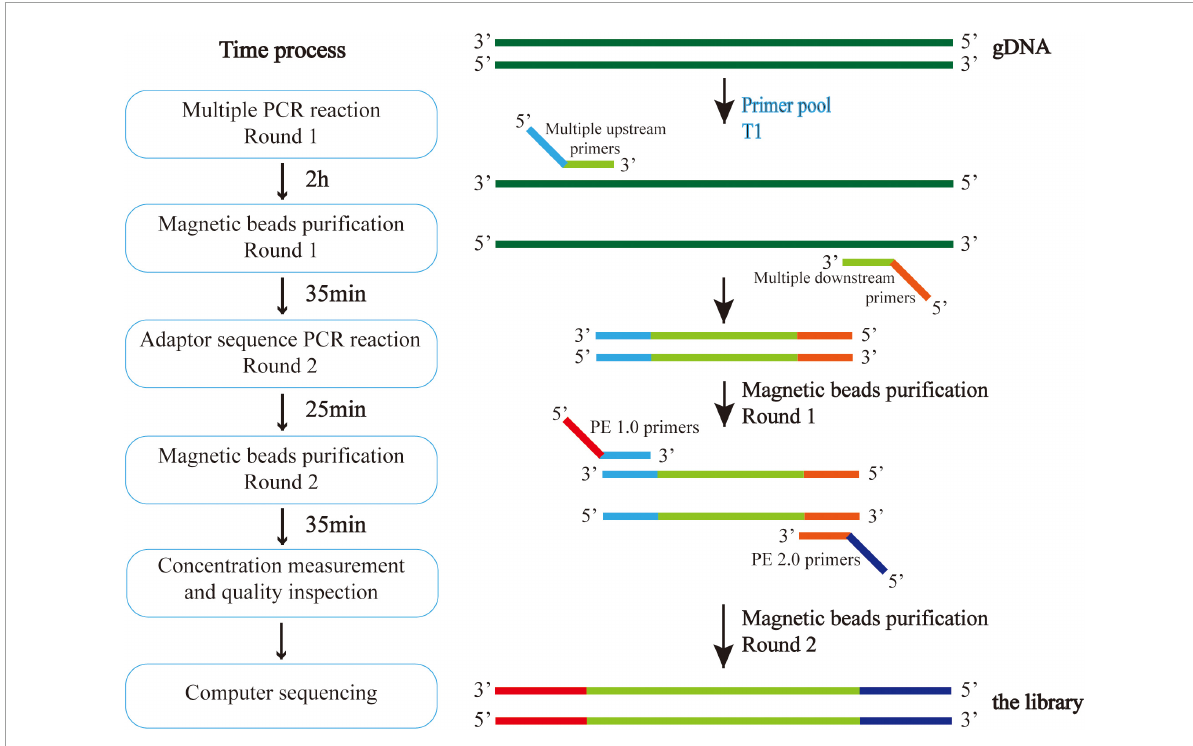
FIGURE2 Multiple PCR technology was used to amplify multiple target regions of genomic DNA at the same time to obtain the amplicon. Then, the second generation sequencing connector was added to both sides of the amplicon by PCR to obtain the amplicon library, and the second generation sequencing was carried out to obtain the sequence information of the target region. The experiment was conducted in strict accordance with the library construction process.